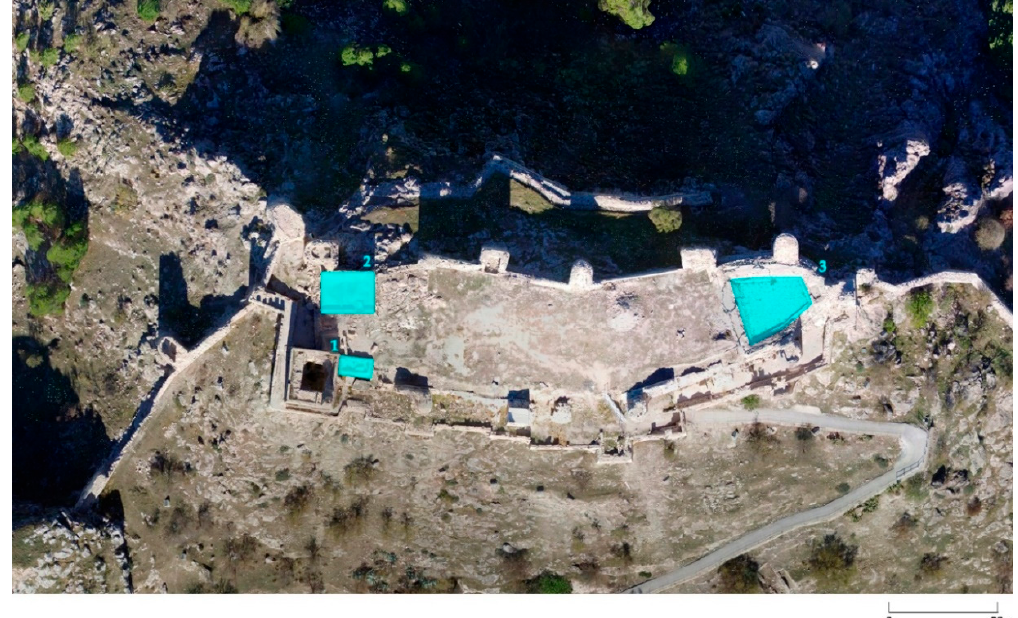
Figure 11. Orto-corrected photogrammetry of the Alcazaba of Moclín. Isolated hydraulic constructions: (1) Oldest cistern, (2) large cistern, and (3) possible collection surface. Created by